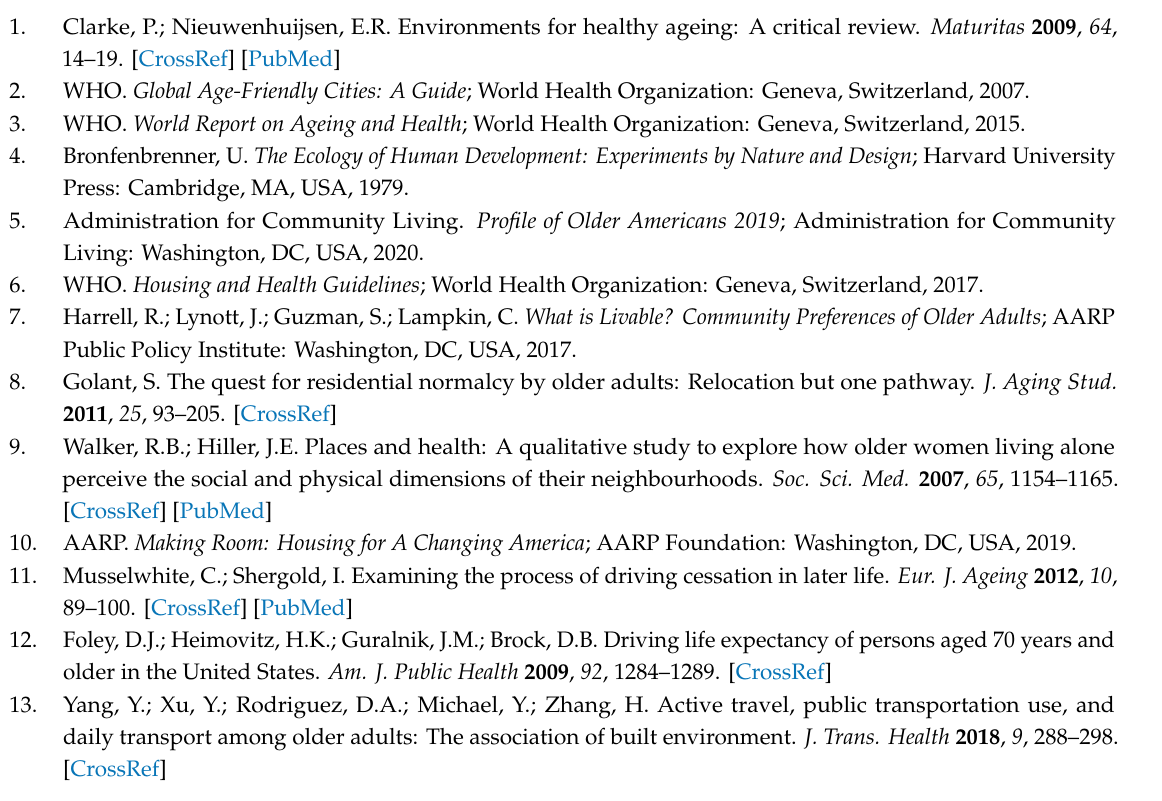
Figure S1: Within groups sum of squares by the number of clusters for K-means cluster